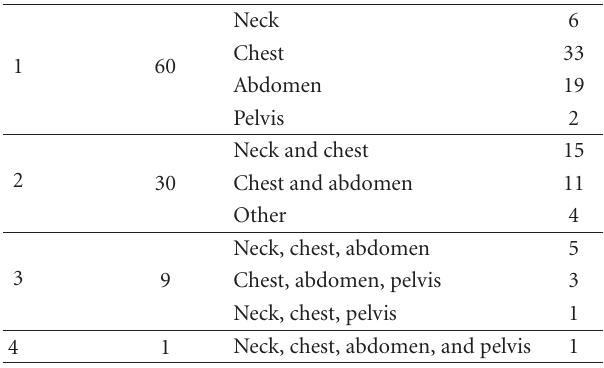
Table 1: Sites of disease at presentation on prechemotherapy CT. For the disease sites, the “neck” includes supraclavicular fossae, and the “chest” includes